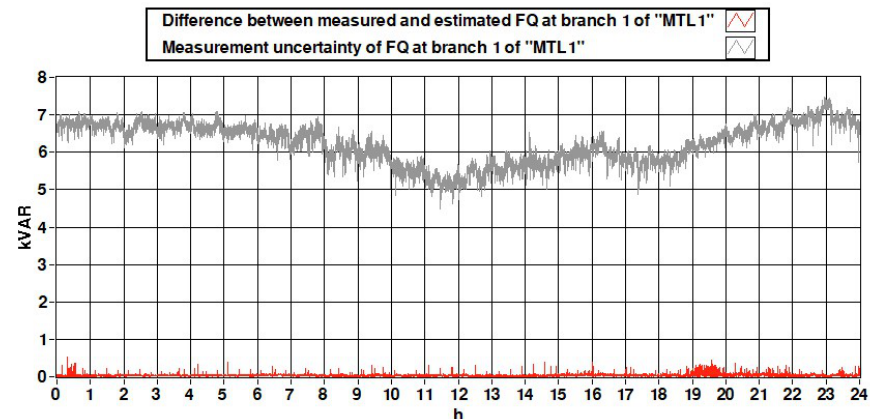
Figure 11. Difference between the measured and the calculated reactive power flow of branch 1 of the “MTL1” line and the uncertainty in its measurement (31 May 2018).